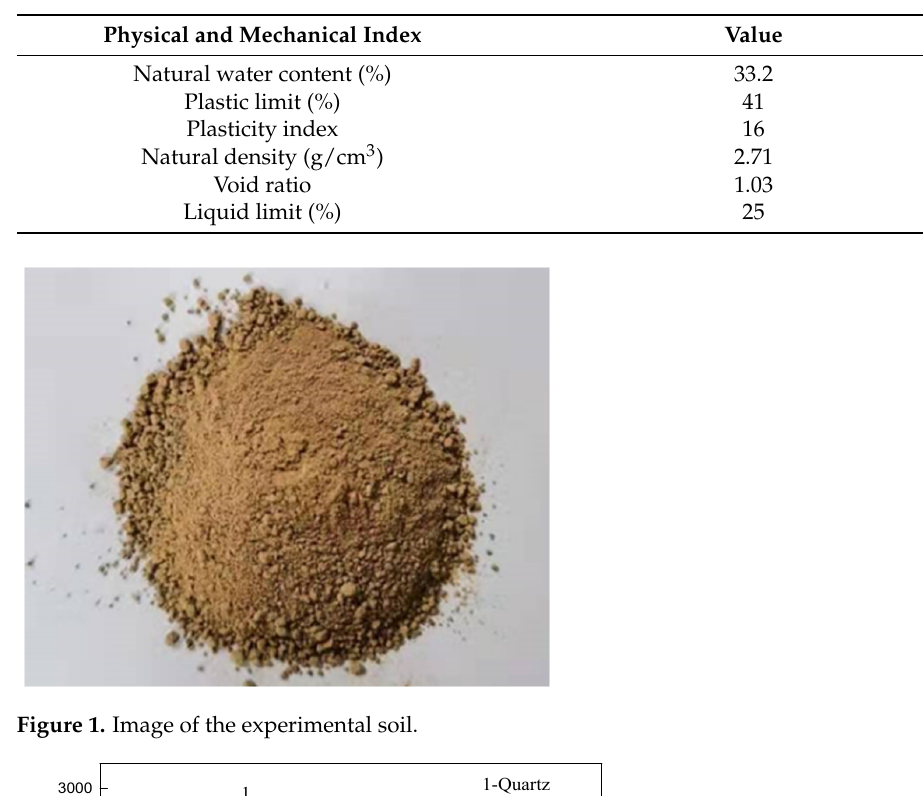
Table 1. Physical indices of the soil.